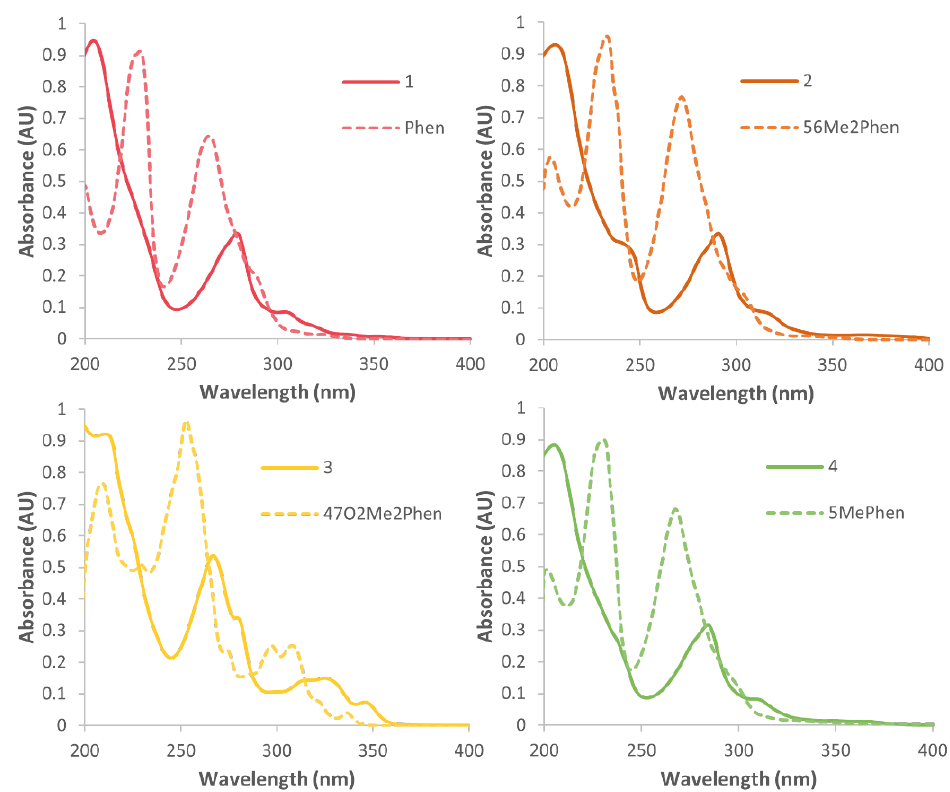
Figure 5. The UV spectra of complexes 1 – 4 overlaid with their corresponding P L , in water.